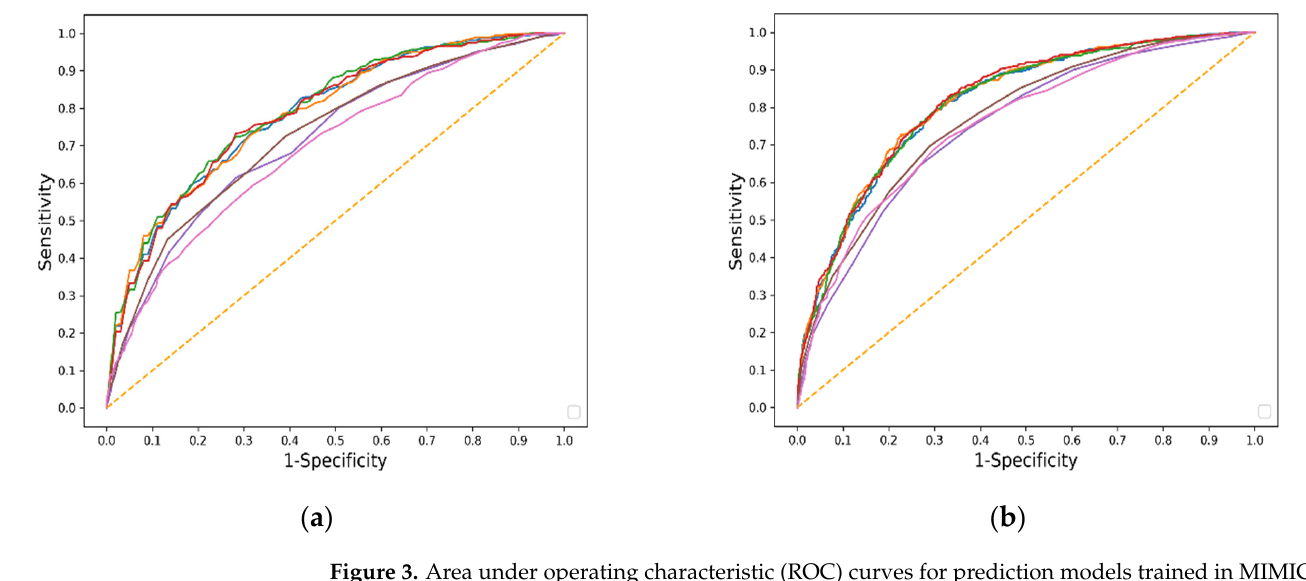
Figure 3. Area under operating characteristic (ROC) curves for prediction models trained in MIMIC ( a ) and tested in eICU ( b ). Red, RF (0.783, 0.816); Green, XGBoost (0.793, 0.812); Blue, MLP (0.785, 0.810); Orange, LR (0.786, 0.815); Brown, nonrenal SOFA score (0.728, 0.769); Purple, SOFA score (0.717, 0.749); Pink, HELENICC score (0.694, 0.756). Table 4. Model performance measures in the pooled